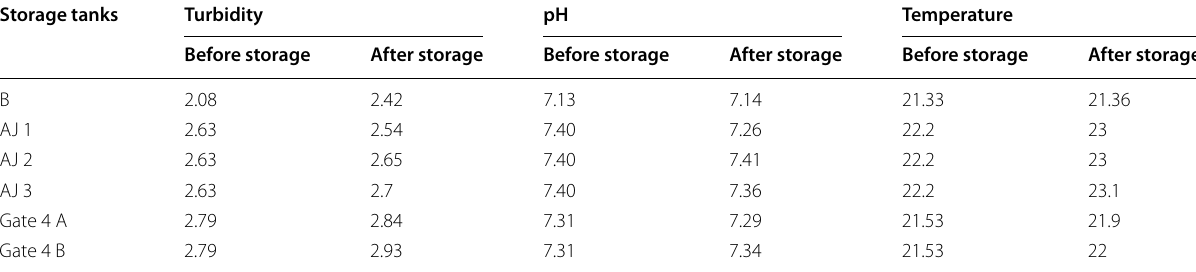
Table 2 Physicochemical quality of water samples stored in storage tanks Storage tanks